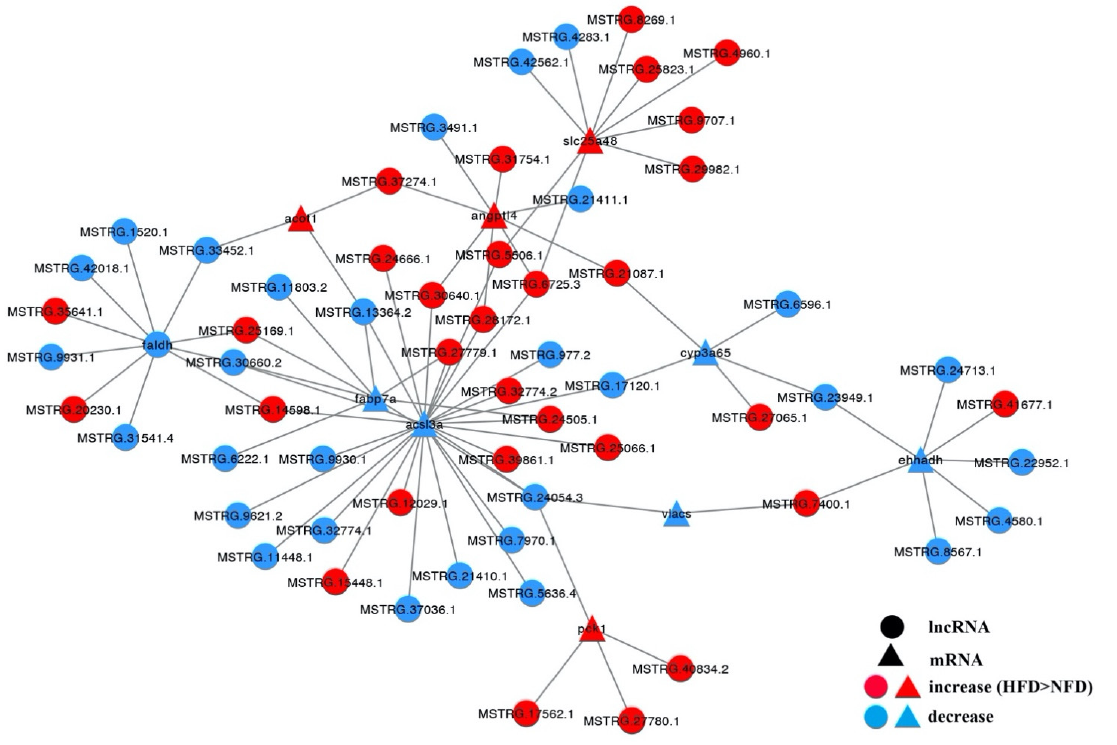
Figure 6. LncRNA–mRNA interaction network in HFD vs. NFD groups. Ellipses represent lncRNAs, triangles represent mRNAs; red represents up-regulation (HFD vs. NFD) and blue represents down- regulation.